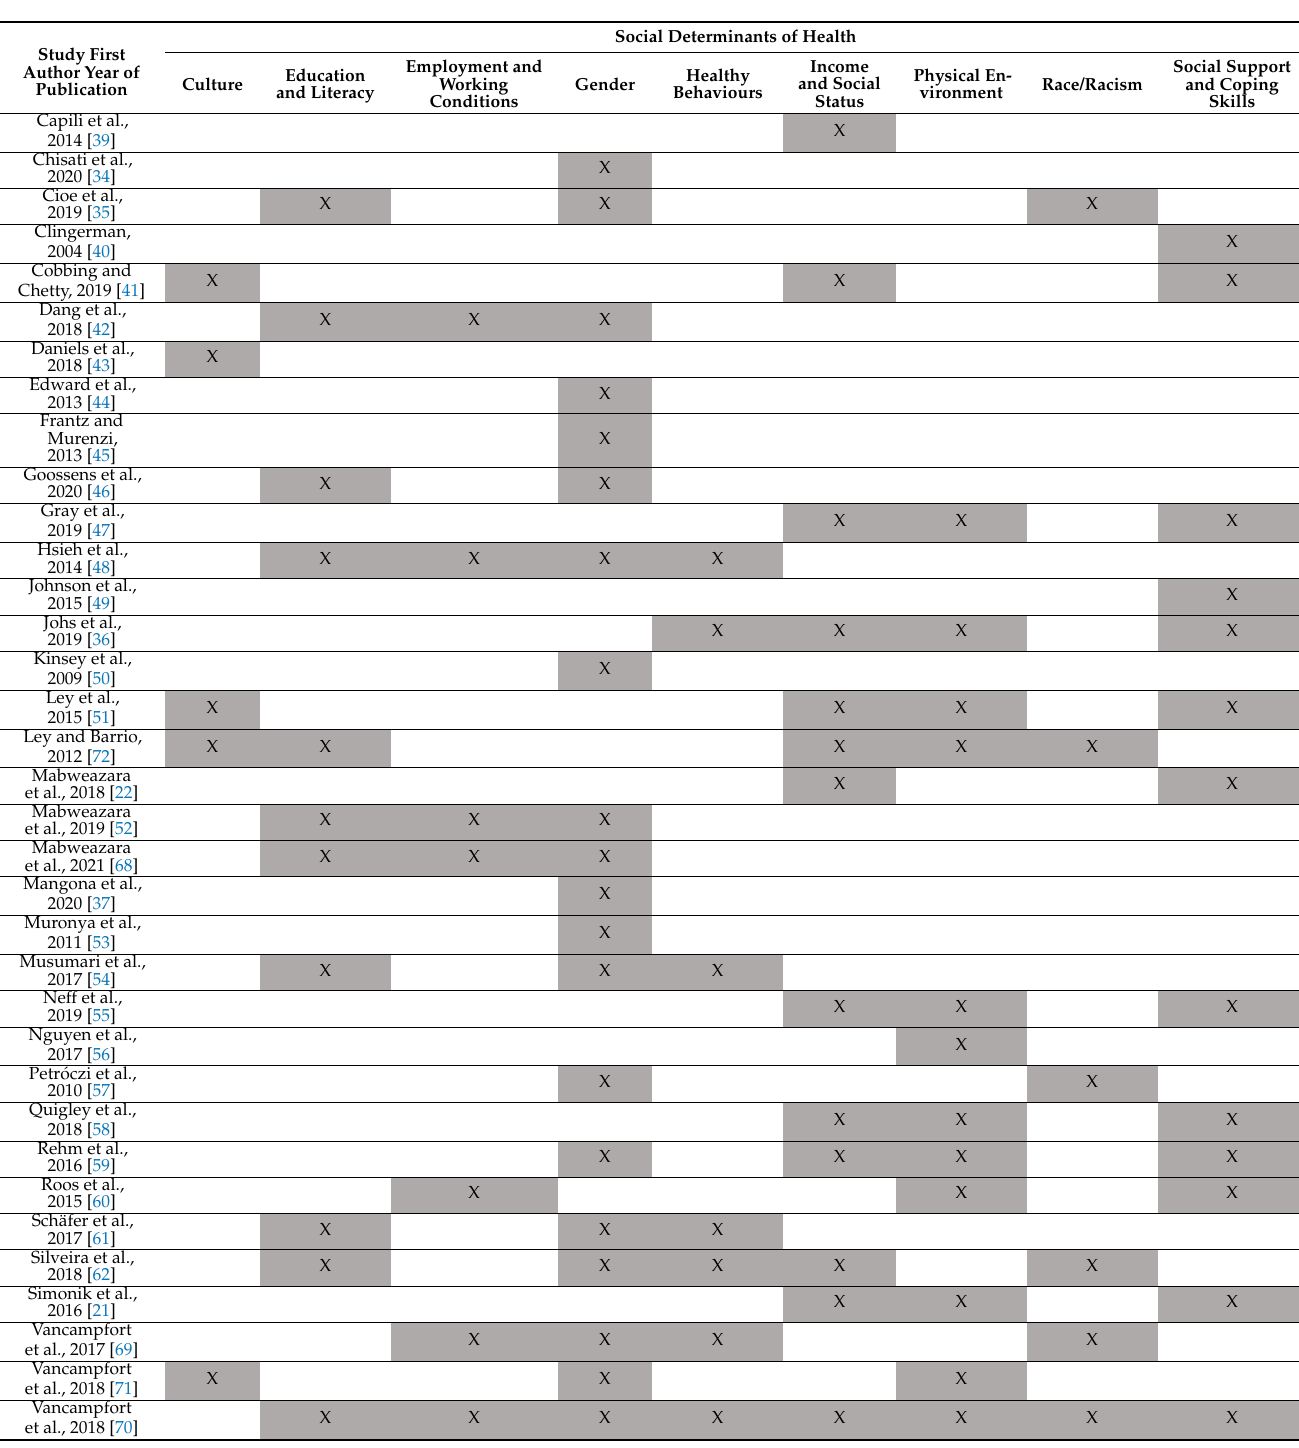
Table 2. Social determinants of health (SDOH) identified in each of the 41 included articles examining physical activity or exercise among adults living with